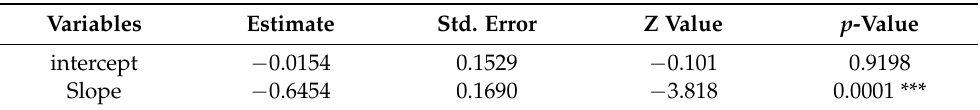
Table 6. Result of the logistic regression predicting tropical forest loss to agriculture with the variable slope. ‘***’ Significant at 0.001 level. Variables Estimate Std. Error Z Value p -Value intercept − 0.0154 0.1529 − 0.101 0.9198 Slope − 0.6454 0.1690 − 3.818 0.0001 ***